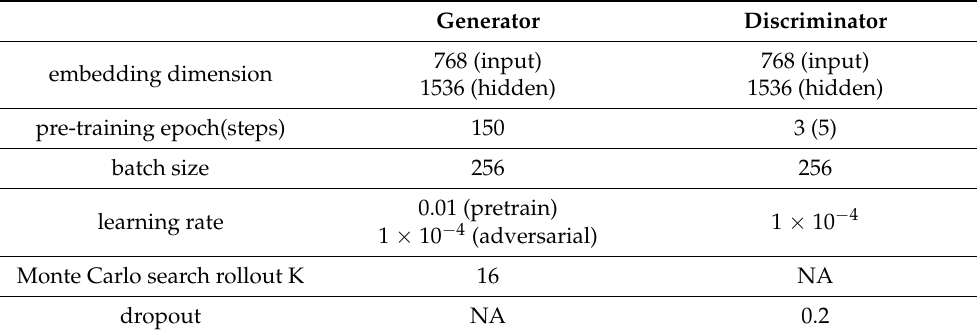
Table 1. The hyperparameters used for training